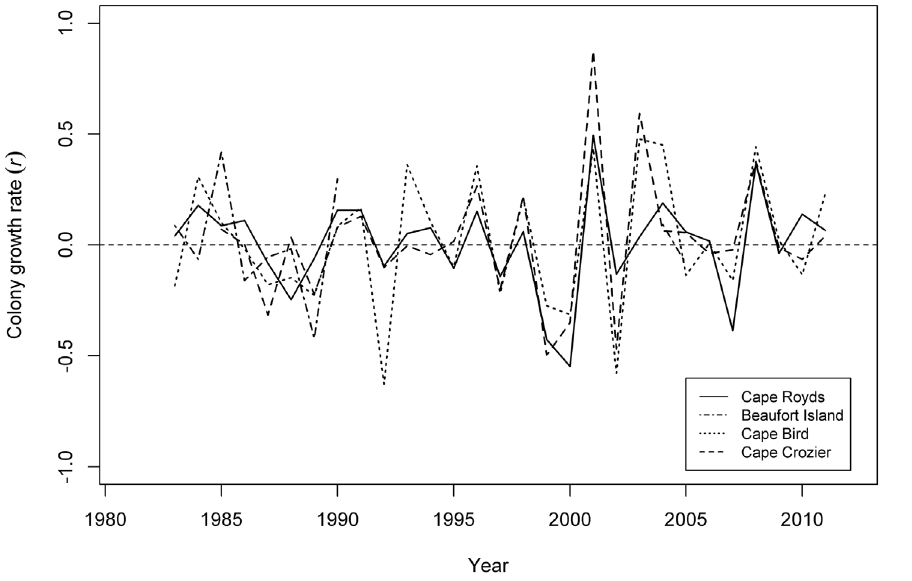
Figure 5. Annual growth rates for Ade´lie penguin colonies at Cape Royds, Cape Bird, Cape Crozier and Beaufort Island, Antarctica from 1981 to 2012.